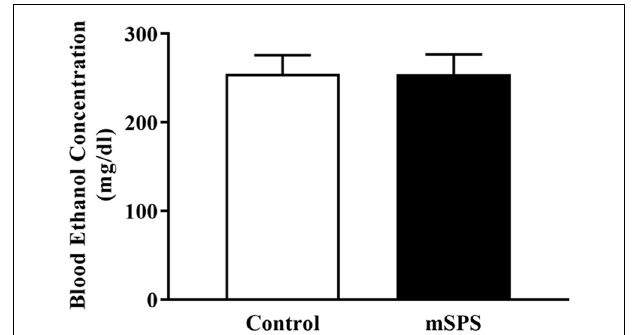
FIGURE 3 | Average blood ethanol concentrations (BECs; mg/dl) across four cycles of CIE vapor exposure. Average BECs in mSPS-CIE mice ( n = 5) over four cycles of CIE vapor exposure did not differ from the Control-CIE mice ( n = 4). Data are mean ± SEM.